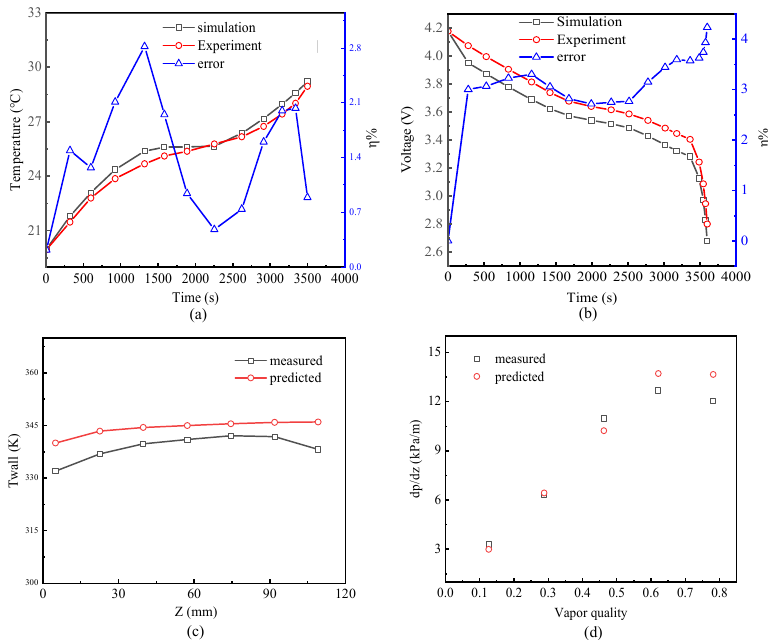
Figure 5. Model verification ( a ) surface temperature of the cell; ( b ) terminal voltage of the cell; ( c ) wall temperature distribution; ( d ) pressure drop gradient.